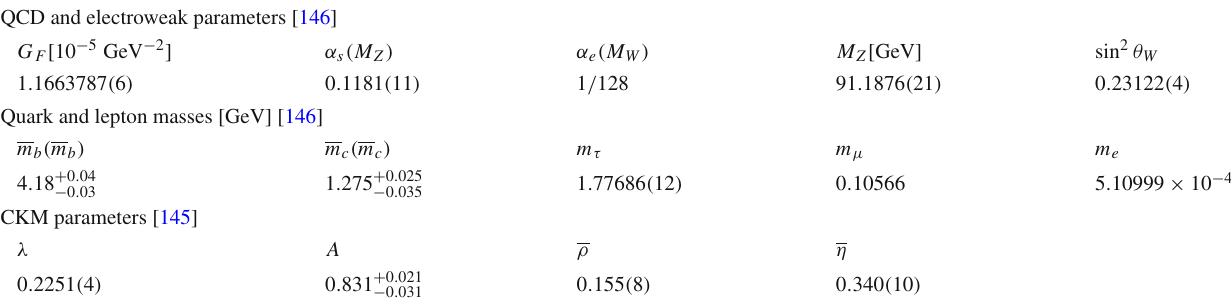
Table 1 Summary of the remaining theoretical input parameters used throughout this paper QCD and electroweak parameters [146] G F [ 10 − 5 GeV − 2